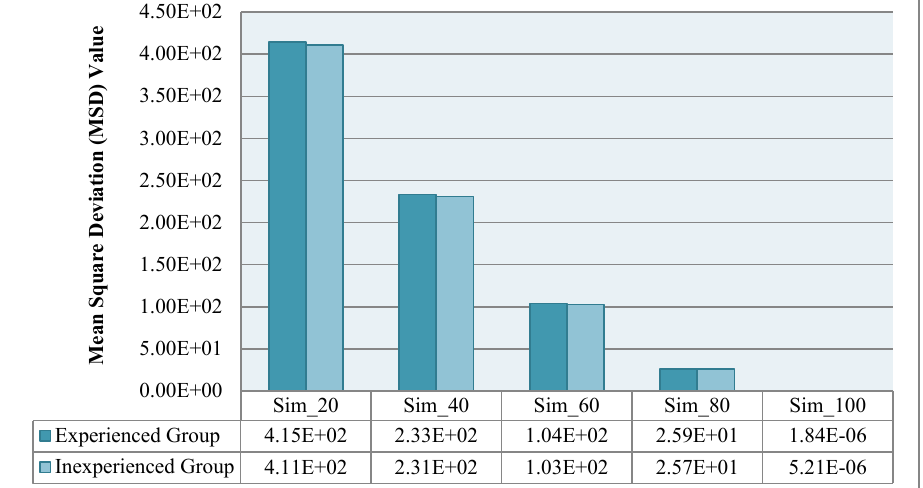
Fig. 6. MSD value comparison of experienced and inexperienced